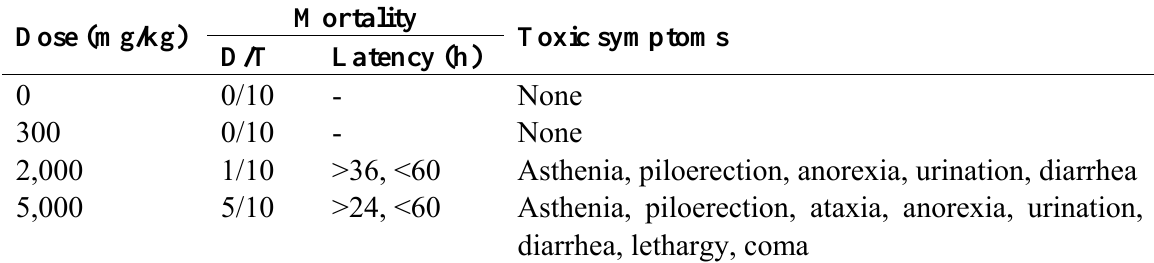
Table 1. Acute oral toxicity of the methanolic extract of Languas galanga rhizomes administered orally to mice.